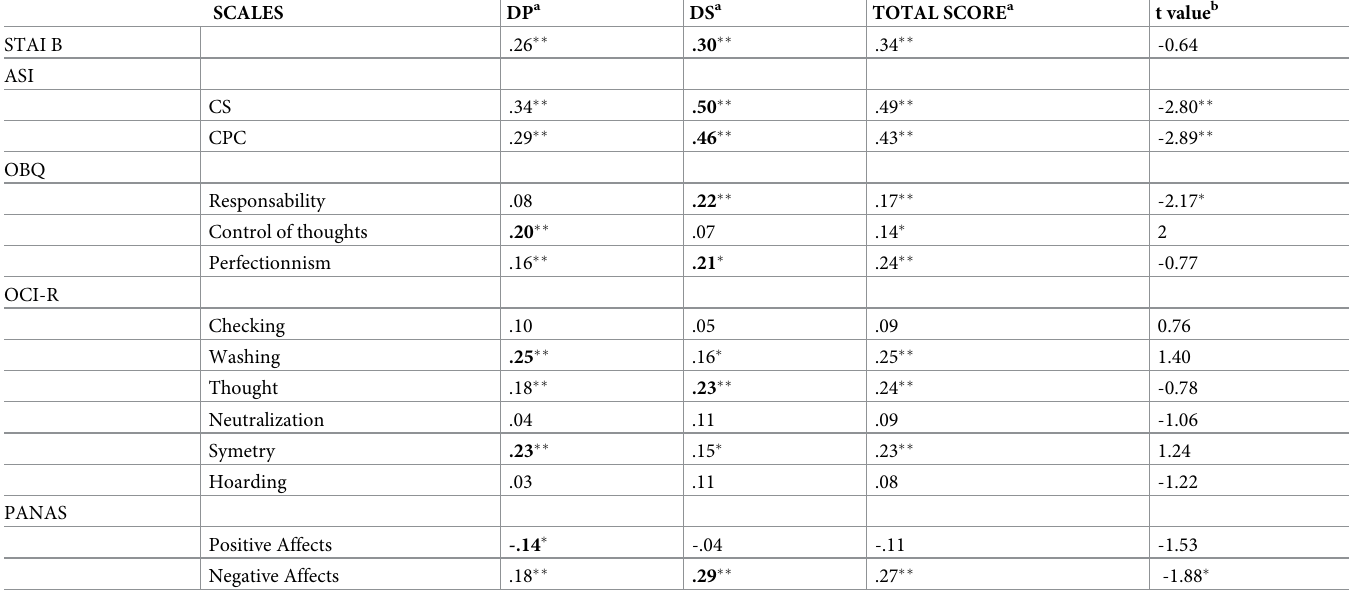
Table 2. DPSSf-10 correlations with convergent and discriminant measures. SCALES DP a DS